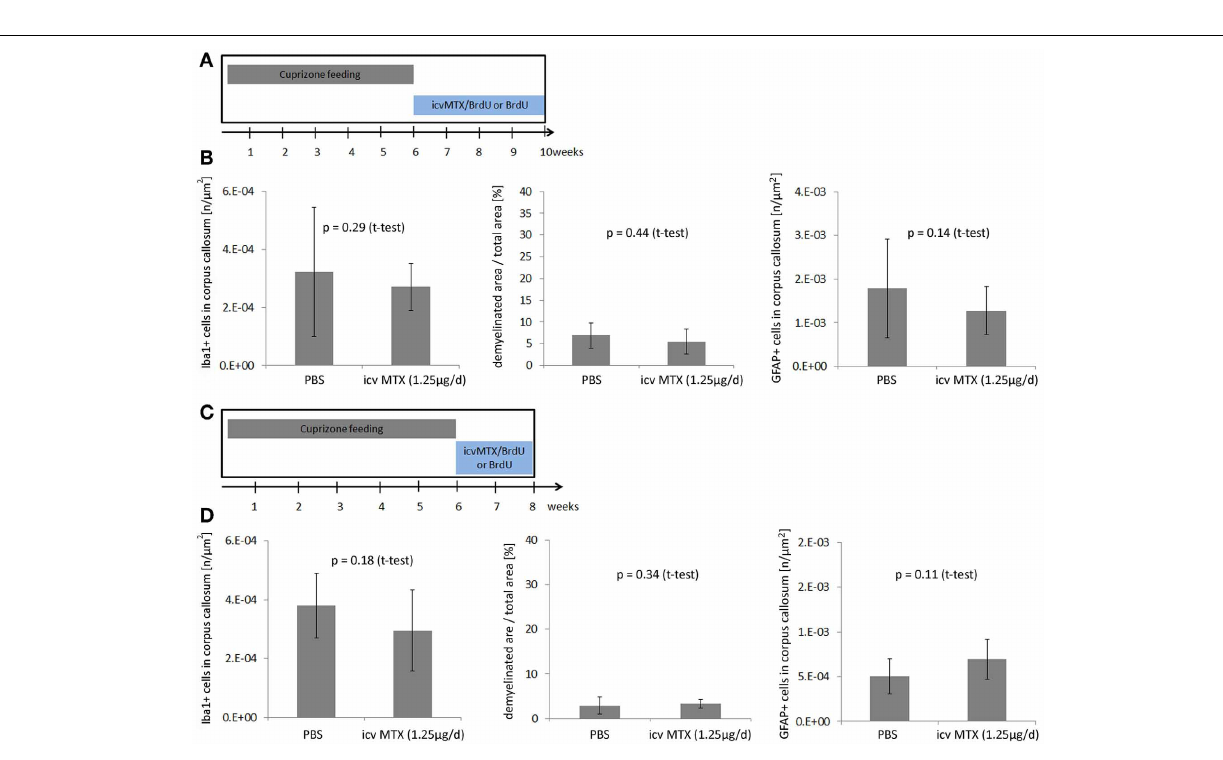
FIGURE 4 | icv MTX administration does not interfere with repair processes after Cuprizone withdrawal. (A) Eight mice per group were fed with cuprizone for a total of 6 weeks. Afterwards mice received either 1.25 µ g/day methotrexate dissolved in 10mg/mL BrdU/PBS intracerebroventricularly or just 10mg/mL BrdU in PBS for another 4 weeks. (B) Quantitative analyses of demyelination and numbers of macrophages/ microglial cells and astrocytes in corpus callosum. Twelve brains slices per